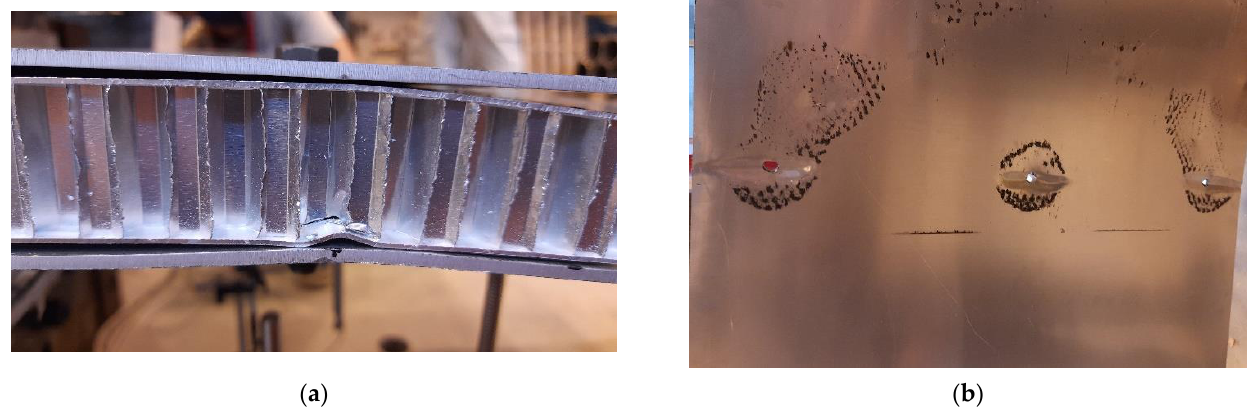
Figure 14. Failed honeycomb panel after the fatigue test at constant amplitude displacements: ( a ) shear crack across a later cell wall; ( b ) skin wrinkling around the bolted connections.